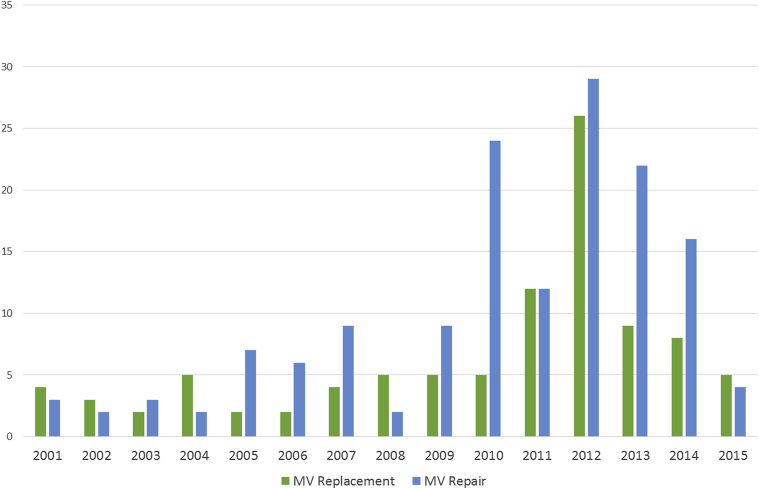
Distribution and type of mitral valve surgeries over the years. MV, Mitral valve.